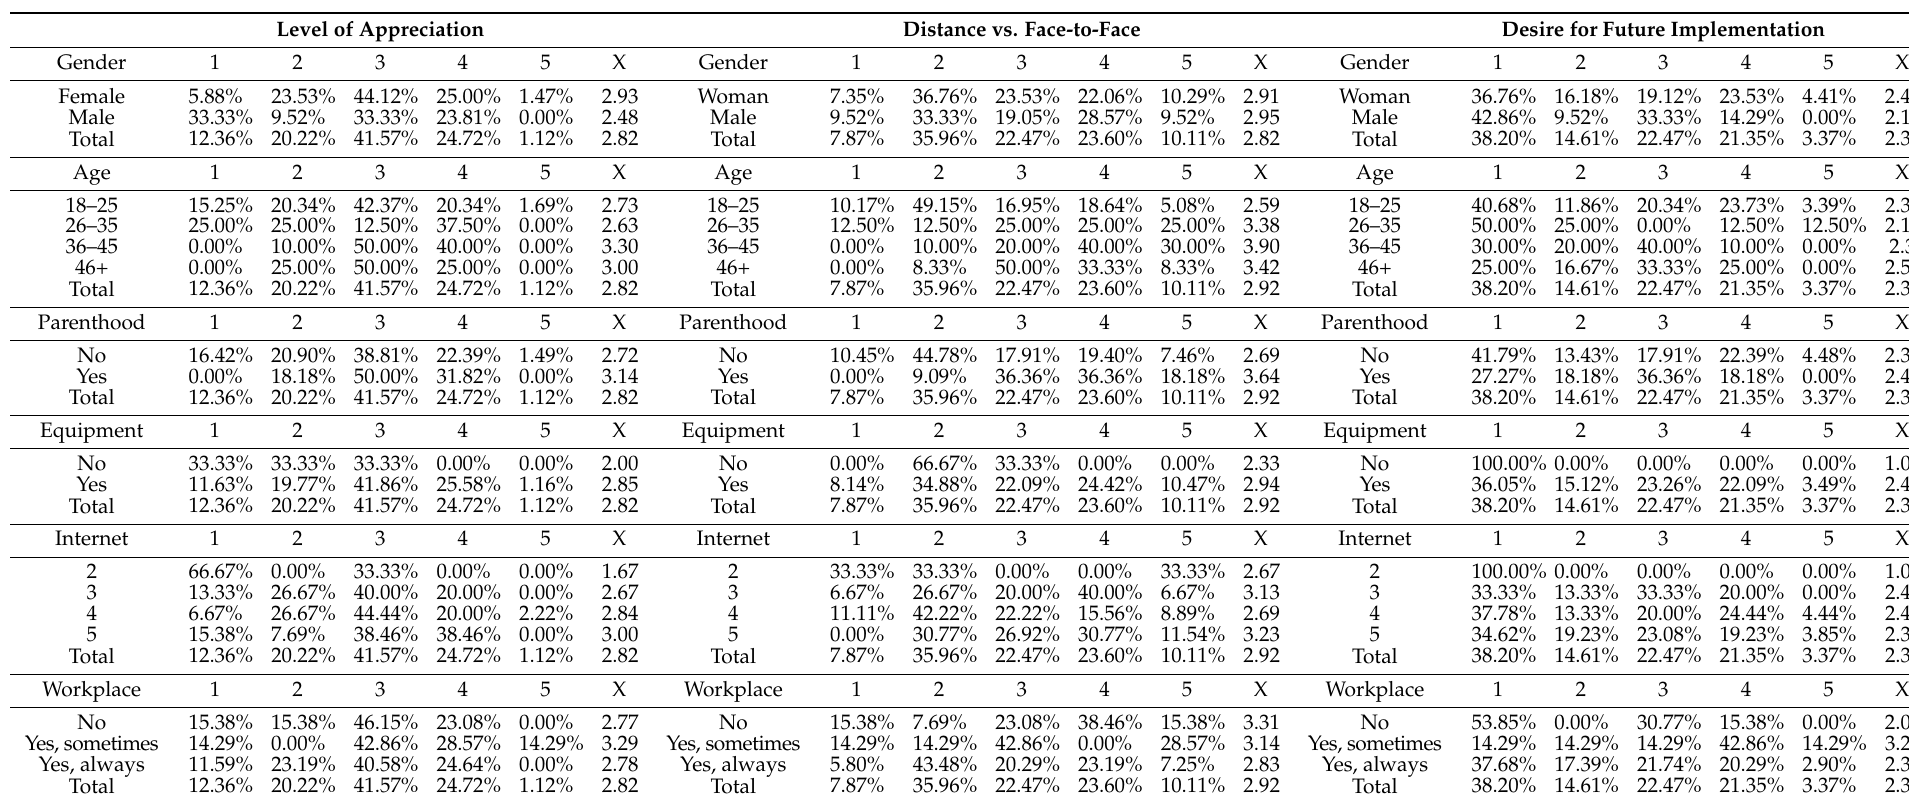
Table A1. Level of appreciation, distance vs. face-to-face, and desire for future implementation vs. gender, age, parenthood, own equipment, internet quality, own workplace. Level of Appreciation Distance vs. Face-to-Face Desire for Future